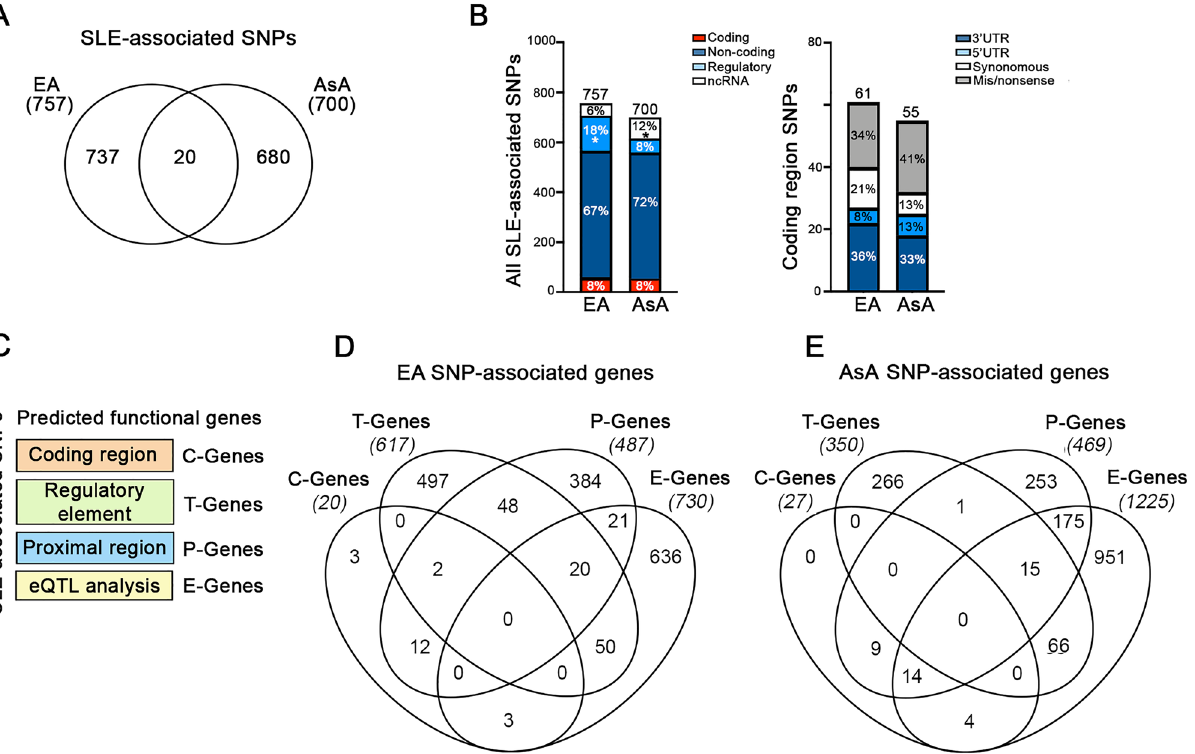
Figure 1. Mapping the functional genes associated with SLE-Immunochip SNPs. ( A ) Venn diagram depicting the ancestral overlap of all SLE-associated Immunochip SNPs. ( B ) Distribution of genomic functional categories for all EA and AsA non-HLA associated SLE SNPs. Genomic category comparisons between ancestral groups were performed using a 2-proportion z test. P values were 2-tailed, and asterisks indicate a significance threshold of p < 0.05. ( C ) Functional SNP-associated genes are derived from 4 sources, including eQTL analysis (E-Genes), regulatory regions (T-Genes), coding regions (C-Genes) and proximal gene-SNP annotation (P-Genes). ( D , E ) Venn diagrams showing the overlap of all EA ( D ) and AsA ( E ) associated E-, T-, C- and